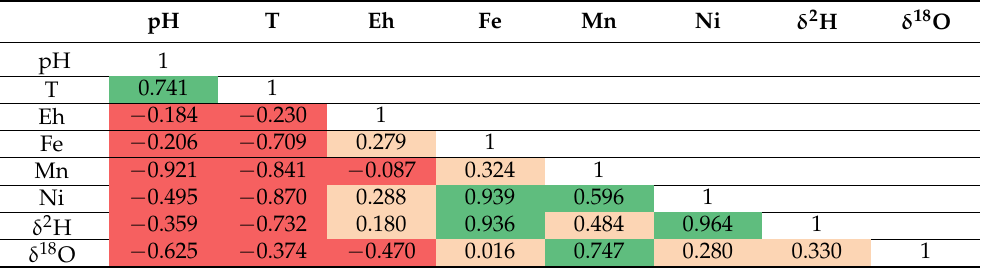
Table 4. Pearson correlation matrix for Case History II (in red fair correlation, in orange moderate correlation and in green high correlation). pH T Eh